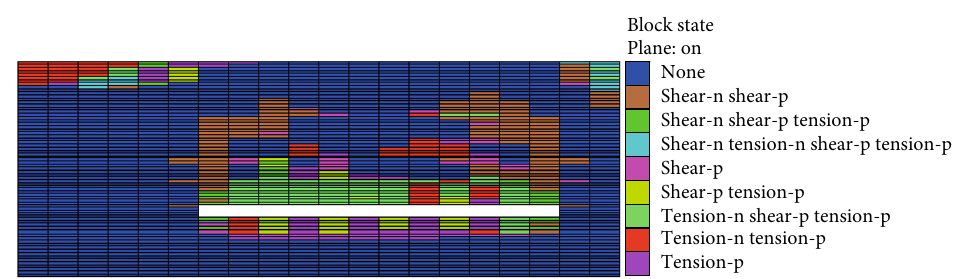
Figure 5: Model unit failure state when mining 120m.